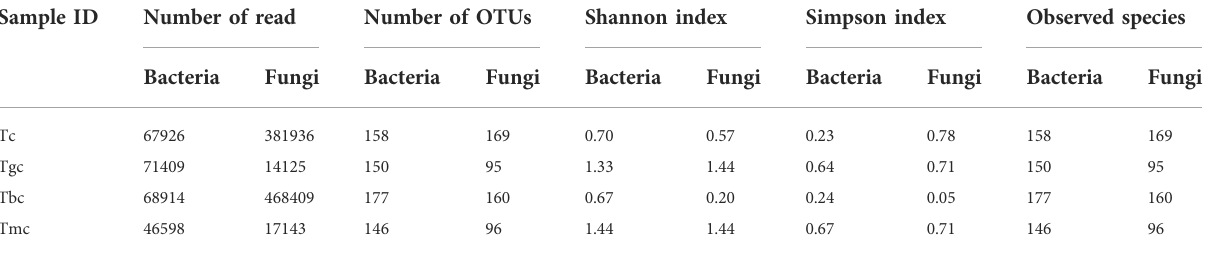
TABLE 6 Alpha diversity pro fi le of control and probiotic-treated